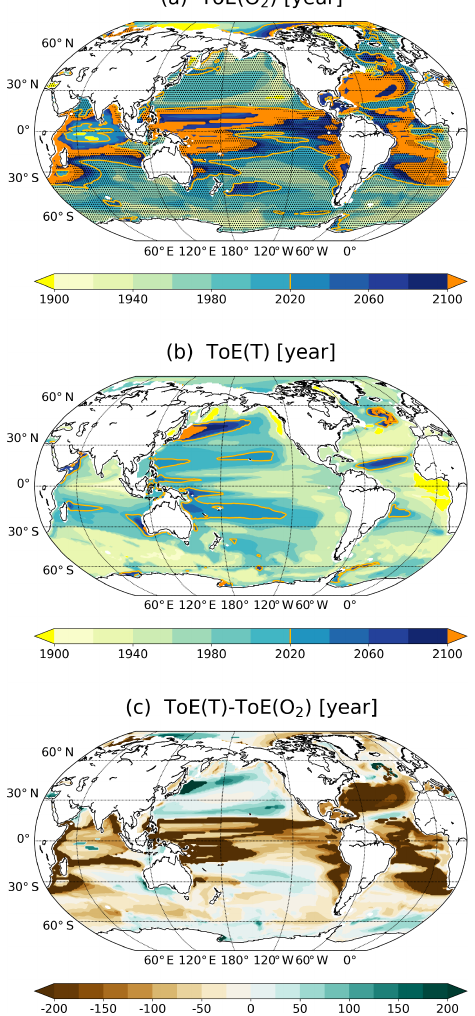
Figure 2. ToE of (a) O 2 , (b) T and (c) their difference in the ther- mocline (200–600m). The dashed areas in panel (a) indicate where O 2 decreases under RCP8.5. Regions where the anthropogenic sig- nal has not emerged by the end of the 21st century are indicated in